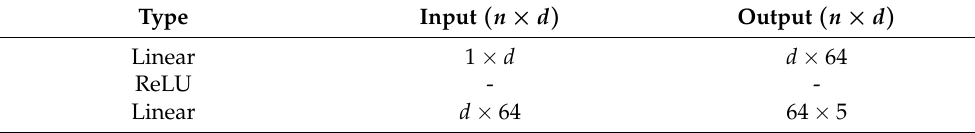
Table 3. RL architecture for Genetic Algorithm for Dataset Base and Dataset Equipment